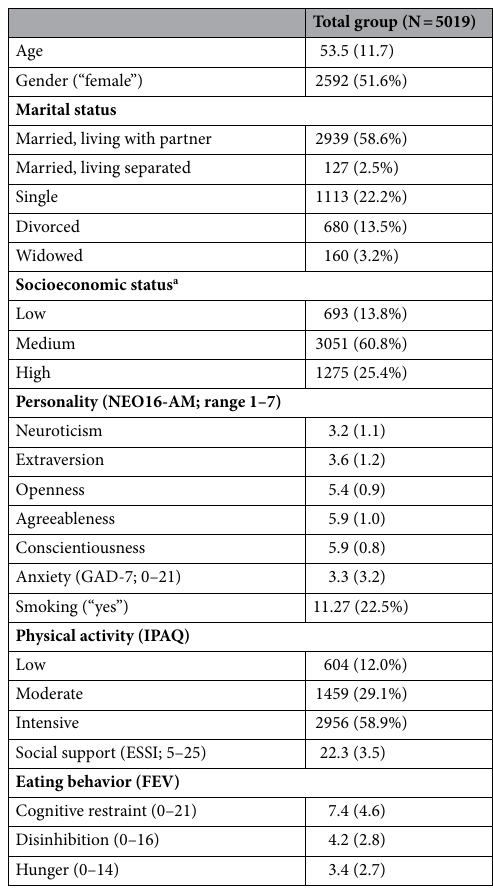
Table 1. General characteristics of the study population. Continuous variables are given as mean (standard deviation); categorical variables are displayed as numbers (percentages). a Socioeconomic status was computed based on education, occupational status, and equivalent household income 29